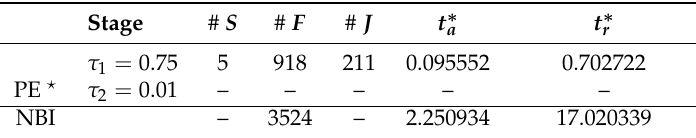
Table 5. Numerical results for the first run with the C-convDTLZ2.